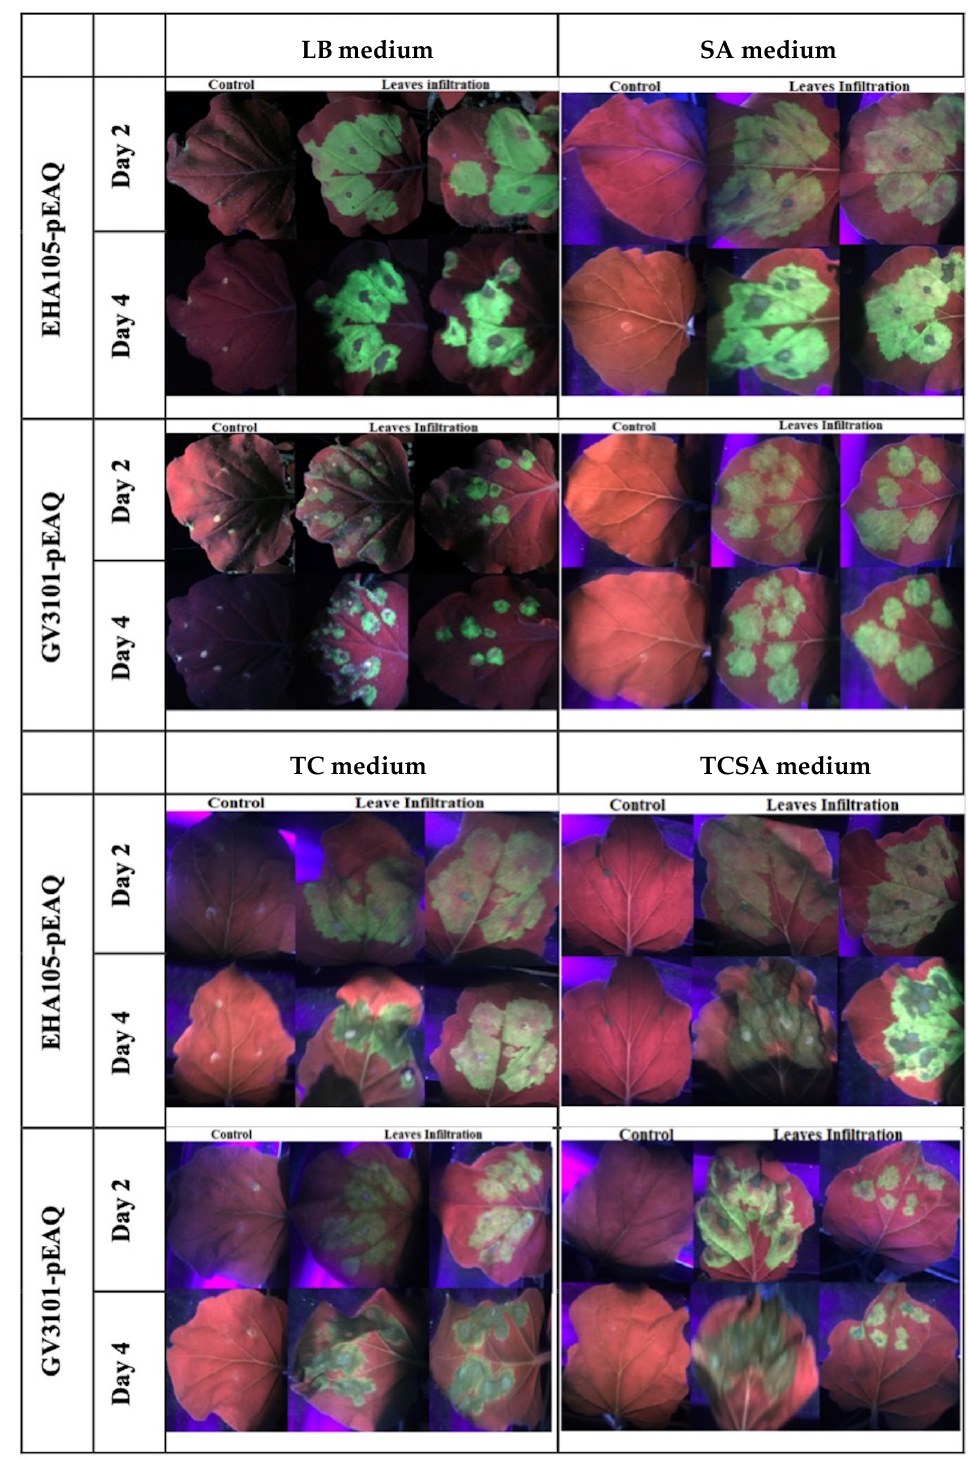
Figure 4. Recombinant green fluorescent protein (GFP) expression in Nicotiana benthamiana leaves using A. tumefaciens EHA105-pEAQ and GV3101-pEAQ strains cultured in LB and molasses-based media for agrobacterium-mediated gene transformation.